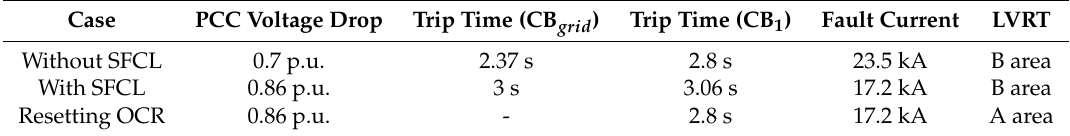
Table 6. Simulation result by